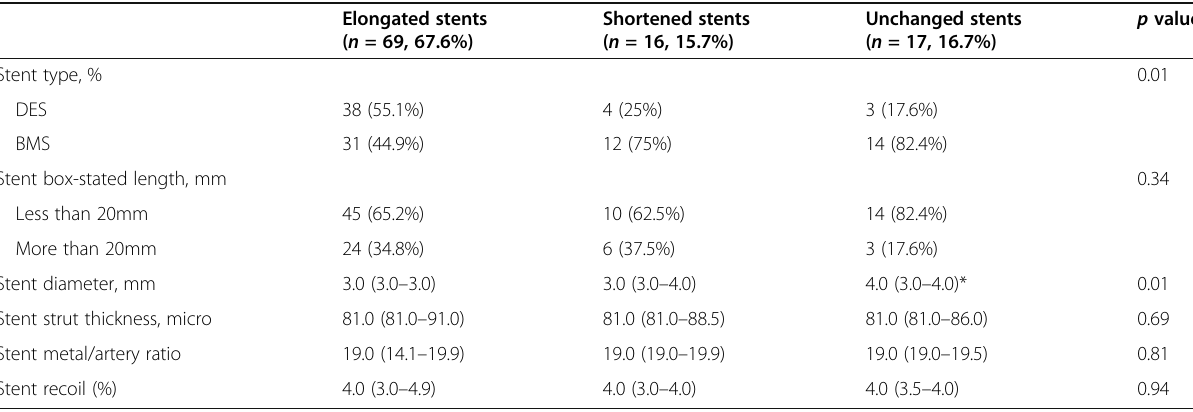
Table 2 Stent types and characters by groups